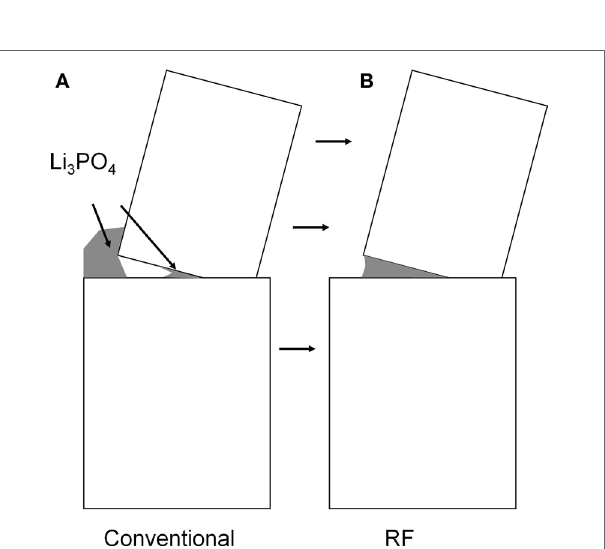
FigUre 12 | grain boundary capacitance of typical conventionally and hF sintered samples .